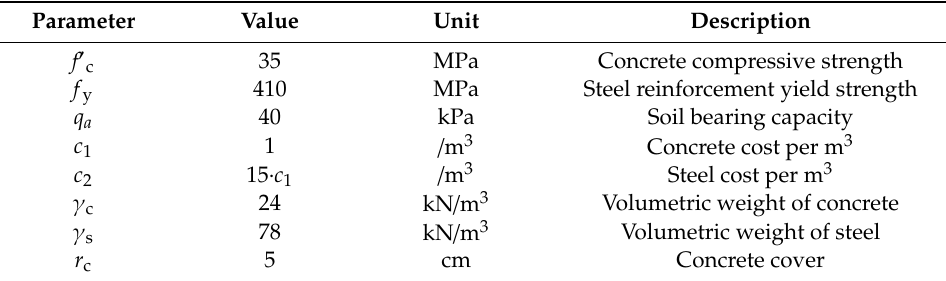
Table 3. Material properties and other parameters.